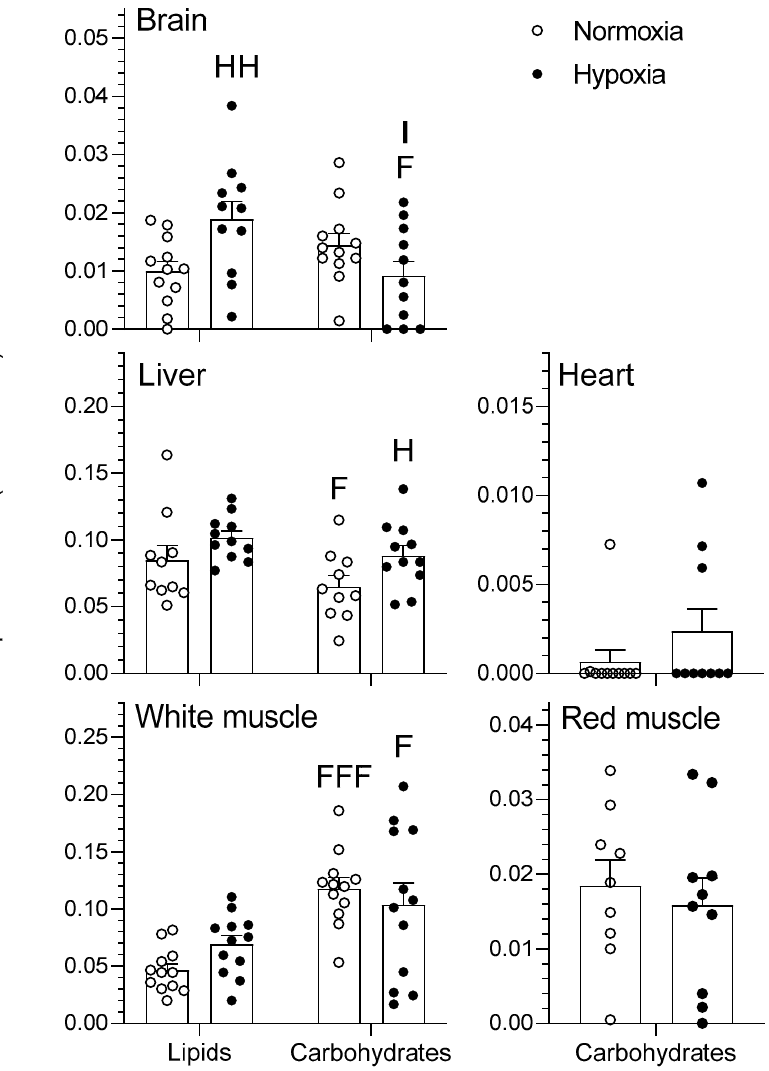
Figure 1. Mitochondrial oxidative fuel preference during nonphosphorylating respiration (LEAK) (pmol O 2 sec − 1 mg − 1 ) normalized to cytochrome c oxidase (COX) respiration in the tissues of normoxic controls ( N = 12) and hypoxia-acclimated goldfish ( N = 11). LEAK represents mitochon- drial respiration in the presence of pyruvate/malate for the carbohydrate protocol and palmitoyl- carnitine/malate for the lipid protocol. Values are means ± standard error of the mean (s.e.m). Dots represent individual data points. Differences between fuels are indicated as F ( p < 0.05) and FFF ( p < 0.001). Differences between oxygen levels are indicated as H ( p < 0.05) and HH ( p < 0.01). Significant interaction between type of fuel and oxygen is indicated as I ( p < 0.05).